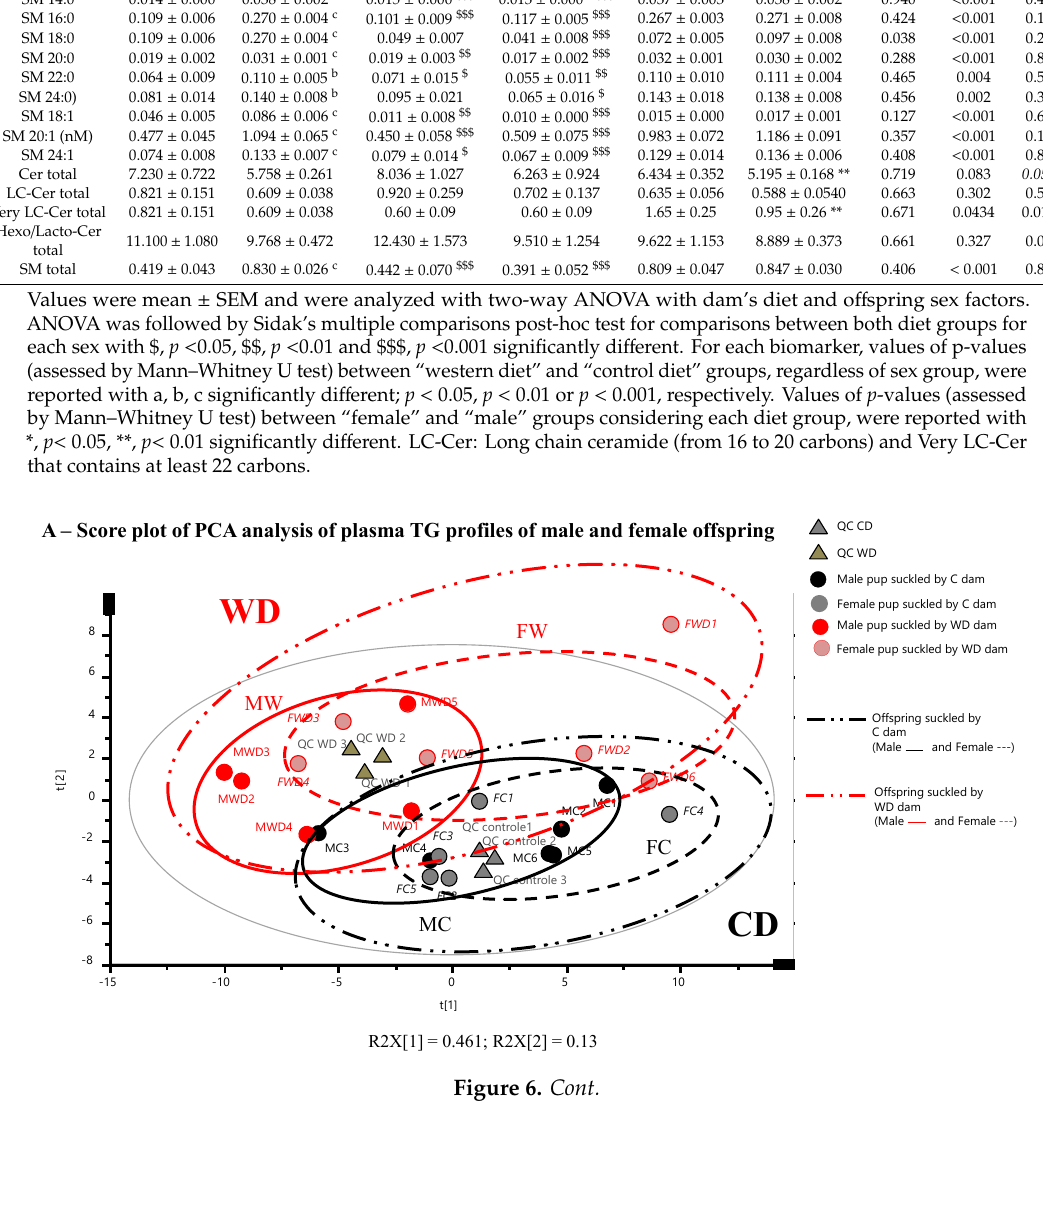
Groups 2-Way ANOVA